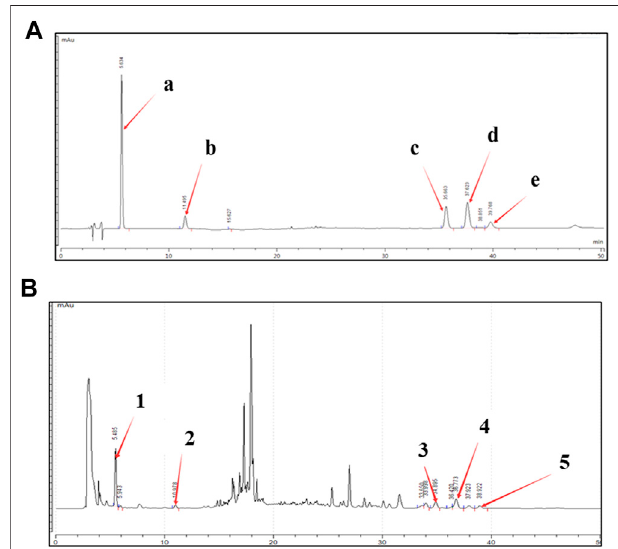
FIGURE 1 | High-performance liquid chromatography (HPLC) chromatogram of the BCW extract. A representative HPLC chromatogram from three batches is shown. (A) HPLC chromatograms of mixed reference solutions of fi ve standards: (i) gallic acid, (ii) protocatechuic acid, (iii) costunolide, (iv) dehydrocostus lactone, ( and (v) dehydrodiisoeugenol. (B) Five main chemical markers were identi fi ed in the BCW extract. The